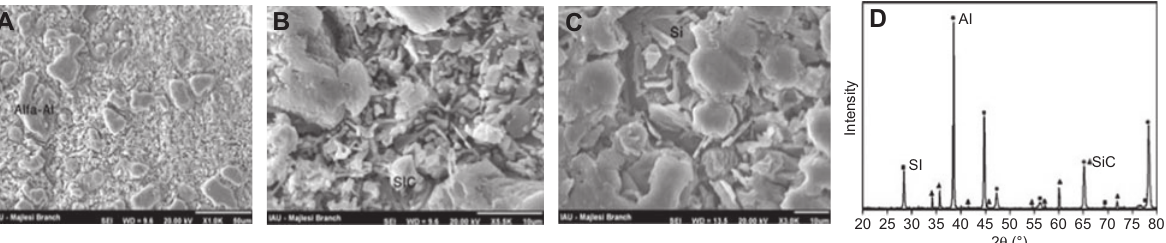
Figure 3 Micrographs of the prepared coating with a current of 75 amp, speed rate of 1 – 3 mm/min and 15 wt. % of SiC (A – C). The micro- structure essentially consisted of SiC particles dispersed in an aluminum alloy matrix. An XRD of coating was prepared under the same condi- tion. An XRD of prepared coating with arc current of 75 amp, speed rate of 1 – 3 mm/min and 15 wt. % of SiC using a power density of 330 MW/m 2 and an interaction time of 0.08 s